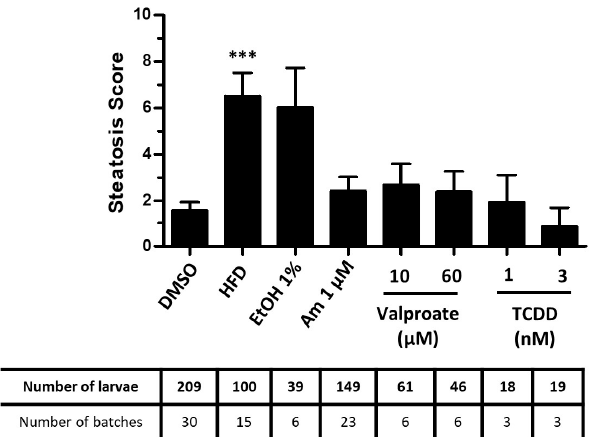
Figure 2. Screening of the steatogenic molecules with the StAZ bioassay. Zebrafish larvae at 3 dpf were exposed to selected steatogenic controls: high-fat diet (HFD), ethanol 1% v / v (EtOH 1%), amiodarone (1 µ M), valproate (10/60 µ M) or TCDD (1/3 nM). Following exposure, larvae were euthanized and fixed, and steatosis score (cf. Figure 1b) was calculated based on Nile red staining and image-based automated analysis after confocal microscopy acquisition. Values are mean +/ − SEM, with the number of batches and larvae indicated in the table underneath the graph. *** p < 0.001, by comparison with control group using Kruskal–Wallis test.